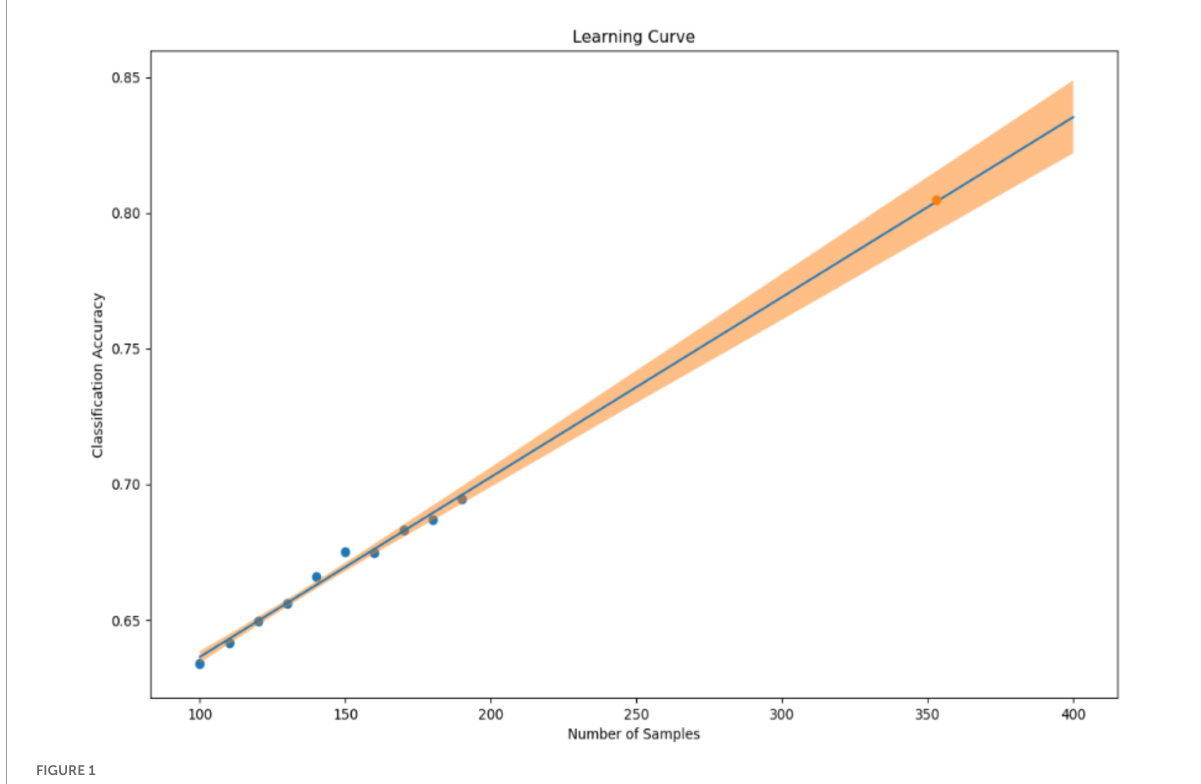
FIGURE1 Sample size (X-axis) and classification accuracy